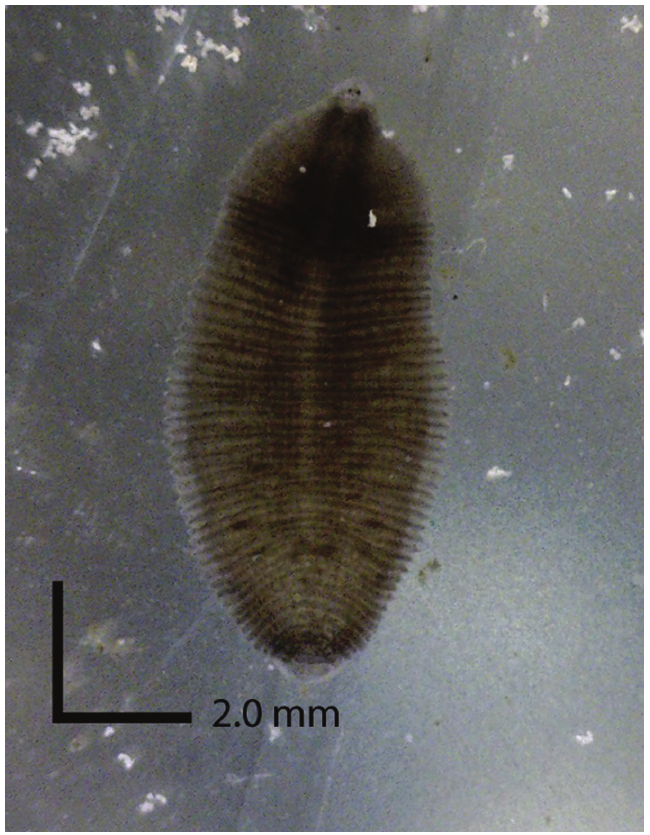
Figure 4. Typical pigmentation of Helobdella blinni sp.